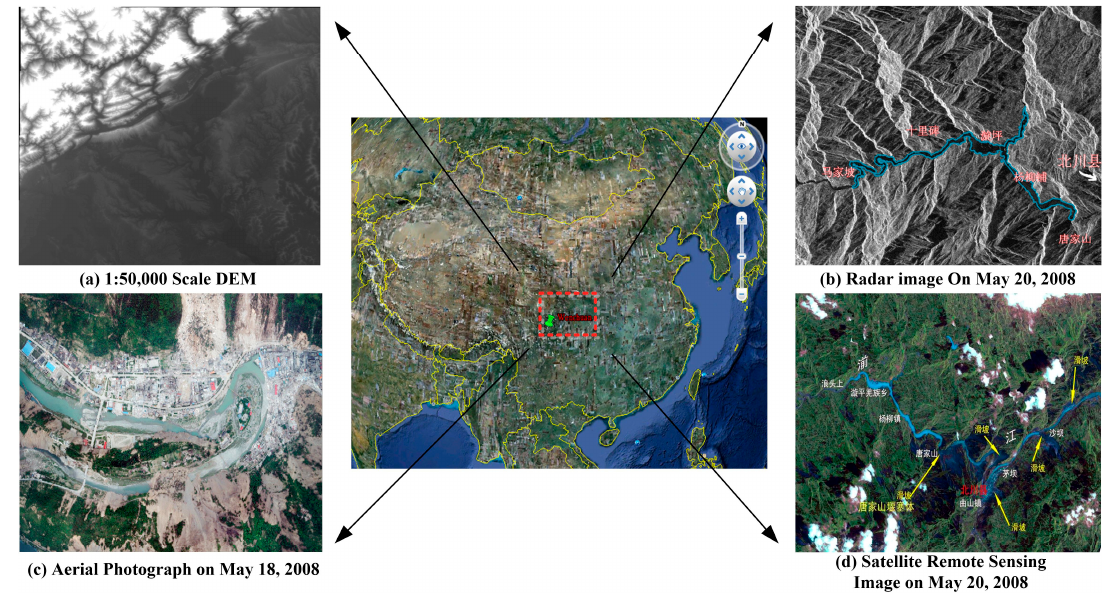
Figure 1. Study area and data. Table 1. Specifications of the satellite remote sensing image, aerial photograph, and satellite radar data used in this study.